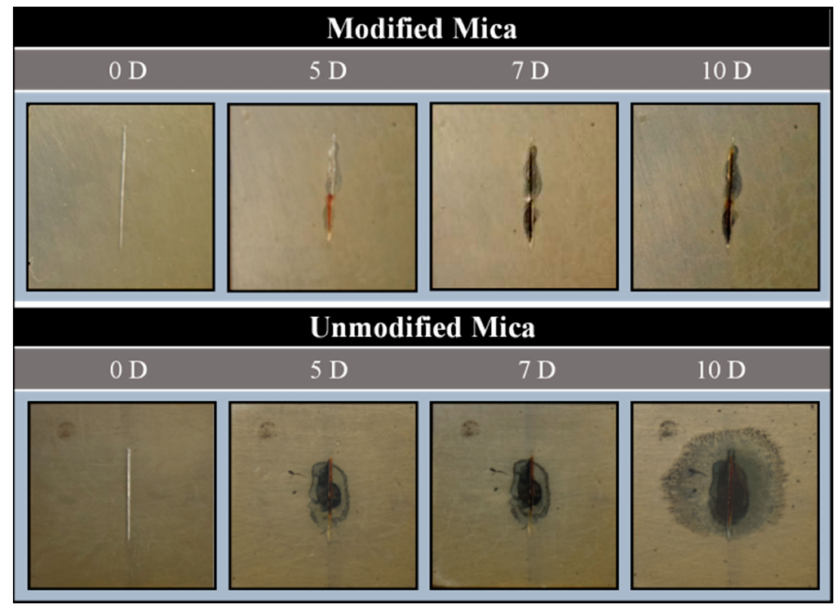
Figure 11. Visual performances of unmodified and modified mica coatings exposed to the salt spray test for different lengths of